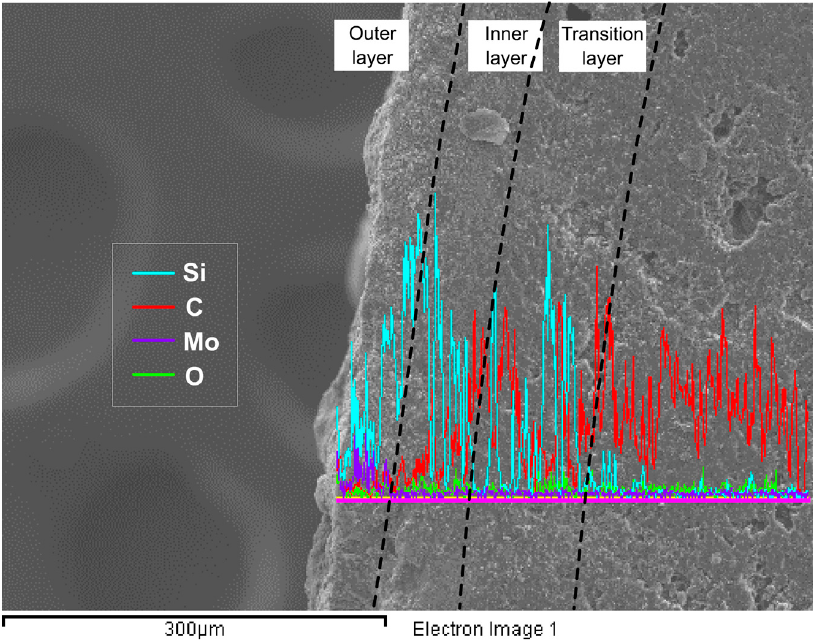
/ C composite coated with MoSi / 2 -Si 3 N 4